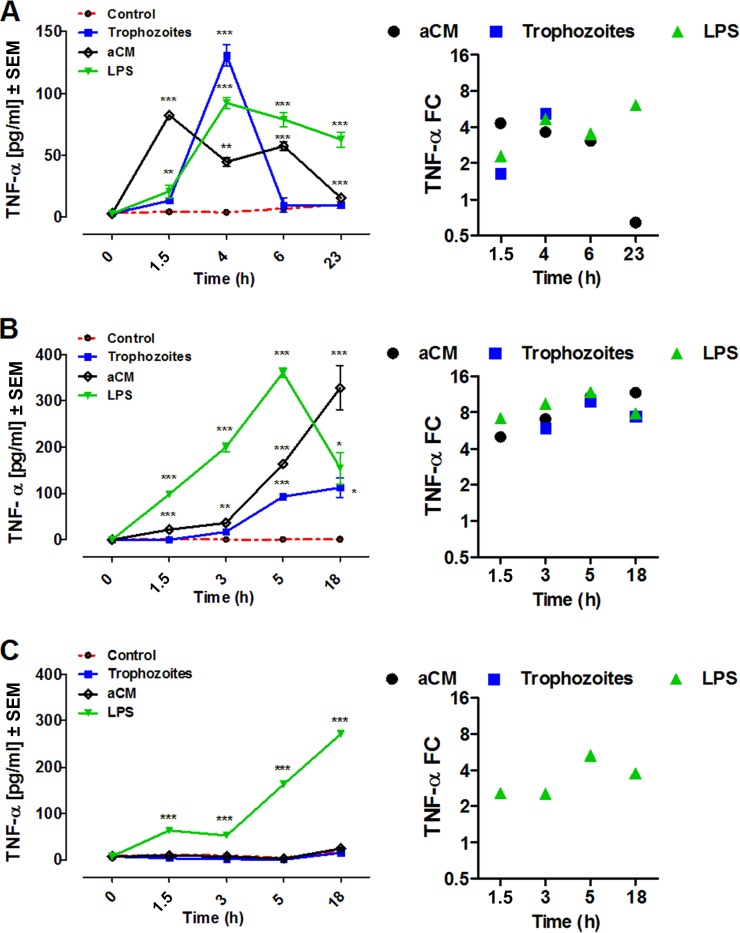
TNF-α production by THP-1 (A), PBMCs (B), and MDMs (C) after coincubation with trophozoites of A. castellanii (trophozoites) or stimulation with aCM. A total of 2 × 105 of either target cells were challenged with either 2 × 104 trophozoites at a ratio of 10:1 or with 800 μl of aCM (final dilution, 4:5 in the culture medium). TNF-α concentration in THP-1 experimental supernatants was evaluated at 1.5, 4, 6, and 23 h poststimulation, whereas in both PBMC and MDM experimental supernatants it was evaluated at 1.5, 3, 5, and 18 h poststimulation. All three cellular models were stimulated with 10 ng/ml LPS as a positive control (LPS), whereas unstimulated cells (control) were considered the negative control. Experiments were performed in triplicate and repeated at least 3 times. Results represent the mean values ± SEM of either n = 5 (THP-1) or n = 3 (PBMCs and MDMs) samples. One-way ANOVA was applied for each time point. Dunnett's multiple-comparison test was performed to evaluate differences between the experimental condition means and the control at each time point. In the graphs, significance between the experimental conditions and the control are indicated as P values of <0.05 (*), <0.005 (**), and <0.0001 (***). On the right, the same results are expressed as fold change (FC) over the unstimulated cells.